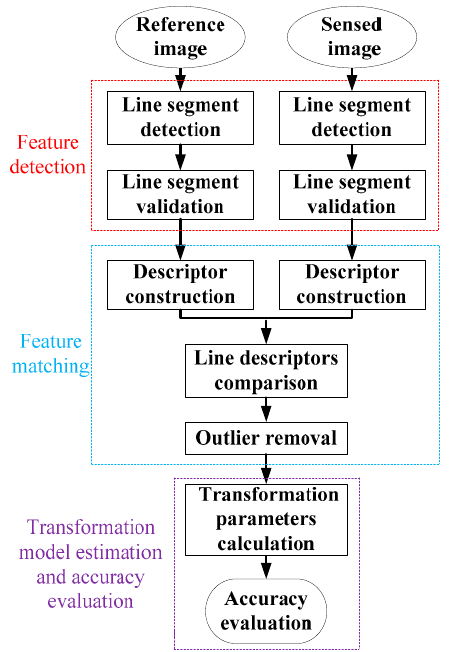
Figure 1. Main steps of the proposed algorithm.